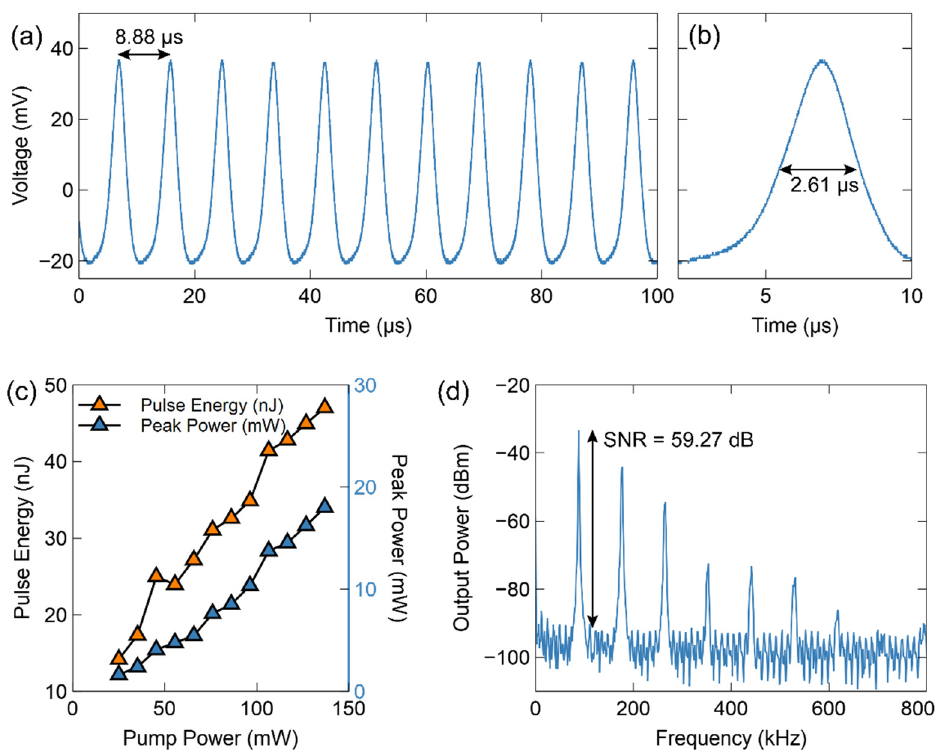
Figure 15. Pump characterisation for MoS 2 -chitin SA; ( a ) Pulse train, ( b ) single pulse profile with pulse width of 2.61 µs, ( c ) variation of pulse energy and peak power against pump power, and ( d ) RFSA measurement.